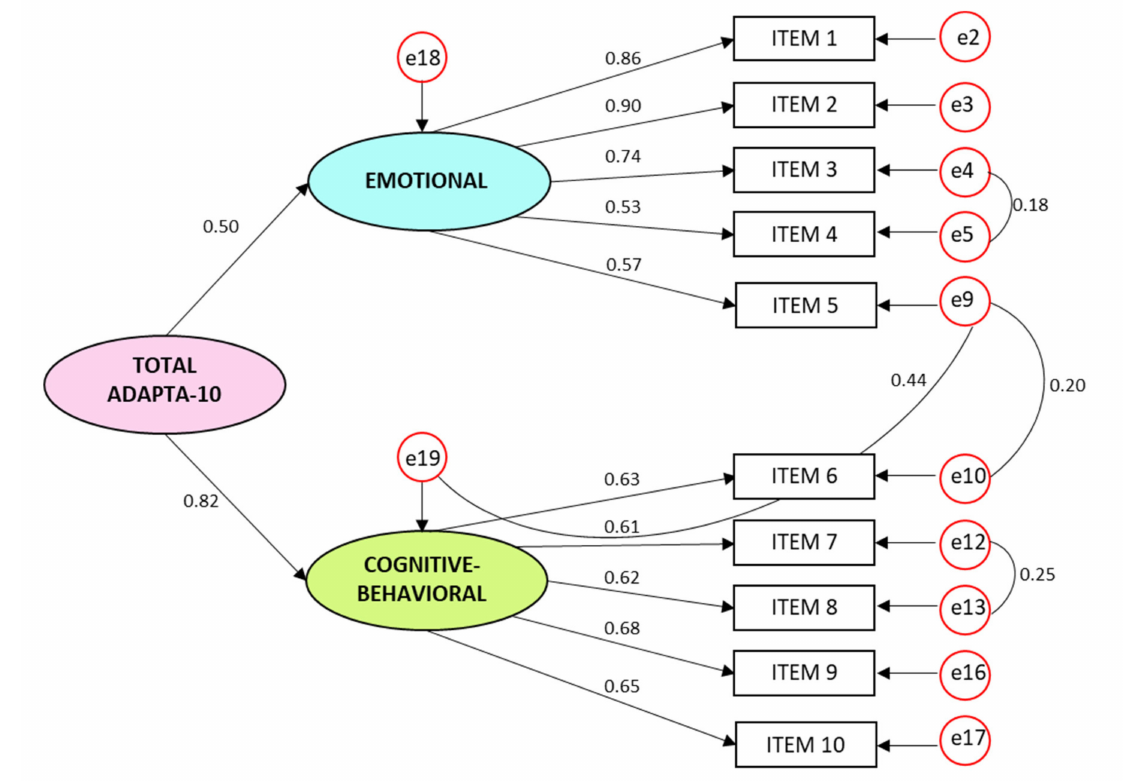
Figure 3. Confirmatory factor analysis ADAPTA-10GF Model ( N = 583).